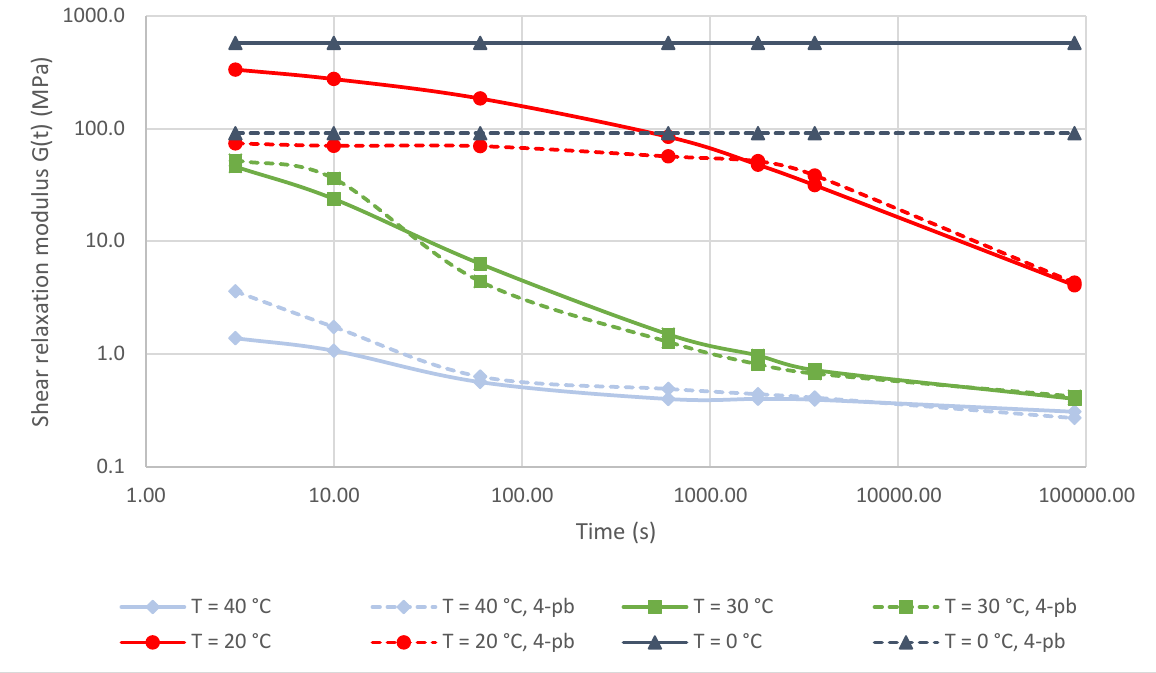
Fig. 8 Shear relaxation modulus for stiff PVB for durations between 3s and 24 hours at different temperatures for the model of Table 3 (solid lines), and as derived from four point bending experiments (dotted lines, Kraus et al.